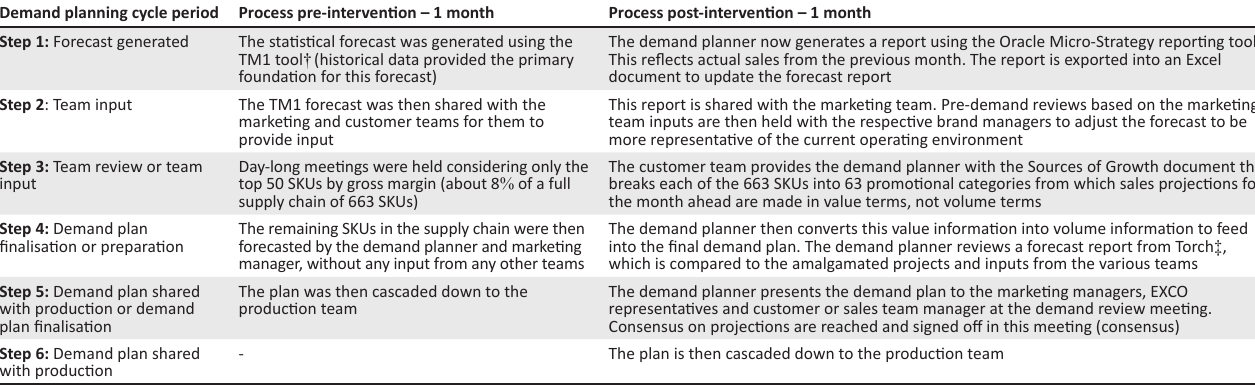
TABLE 3: Comparison: Pre- and post-intervention demand planning